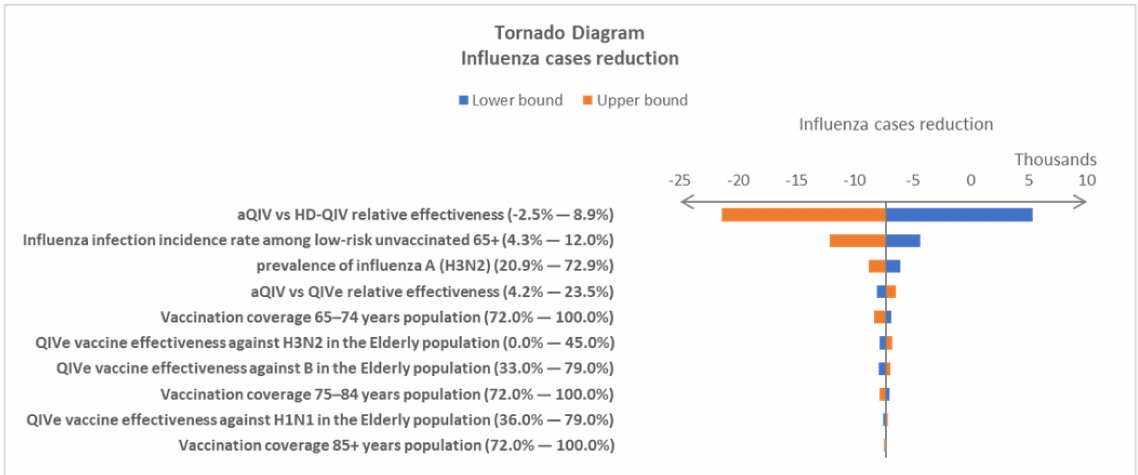
Figure 3. Top 10 most influential factors driving influenza case reduction in the comparison of adopting aQIV vs. HD-QIV in the National Immunization Program (NIP) for the elderly population in South Korea. The values in parenthesis are the minimum and maximum values tested in the deterministic sensitivity analysis (DSA). aQIV—MF59 ® -adjuvanted quadrivalent influenza vaccine;